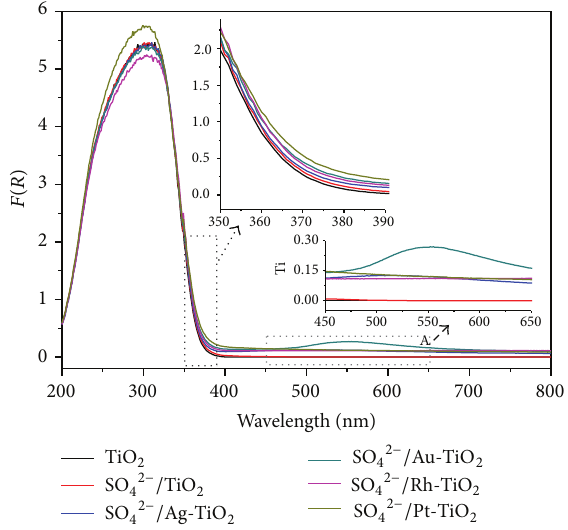
Figure 4: UV-vis DRS of the